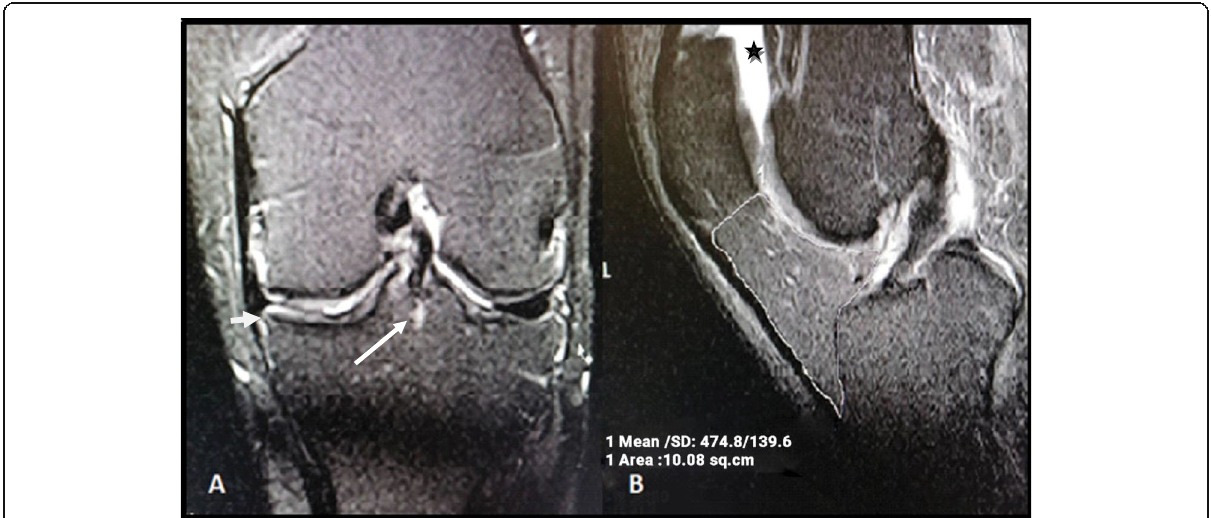
Fig. 3 Mild osteoarthritis on MRI. a Coronal STIR image showing early OA with small marginal osteophite (short arrow) and small subchondral BML (long arrow). b Sagittal T2WI with fat saturation showing the corresponding IPFP area = 10 cm 2 (astride = knee